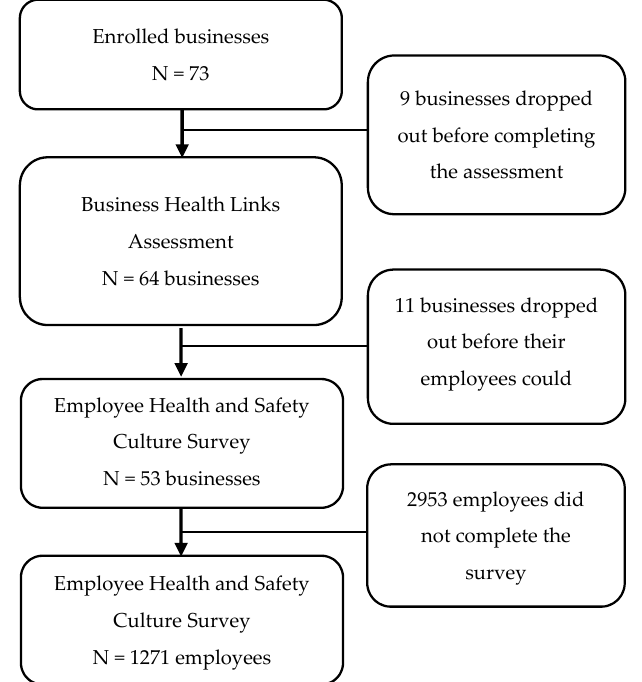
Figure 2. Study enrollment and flow.